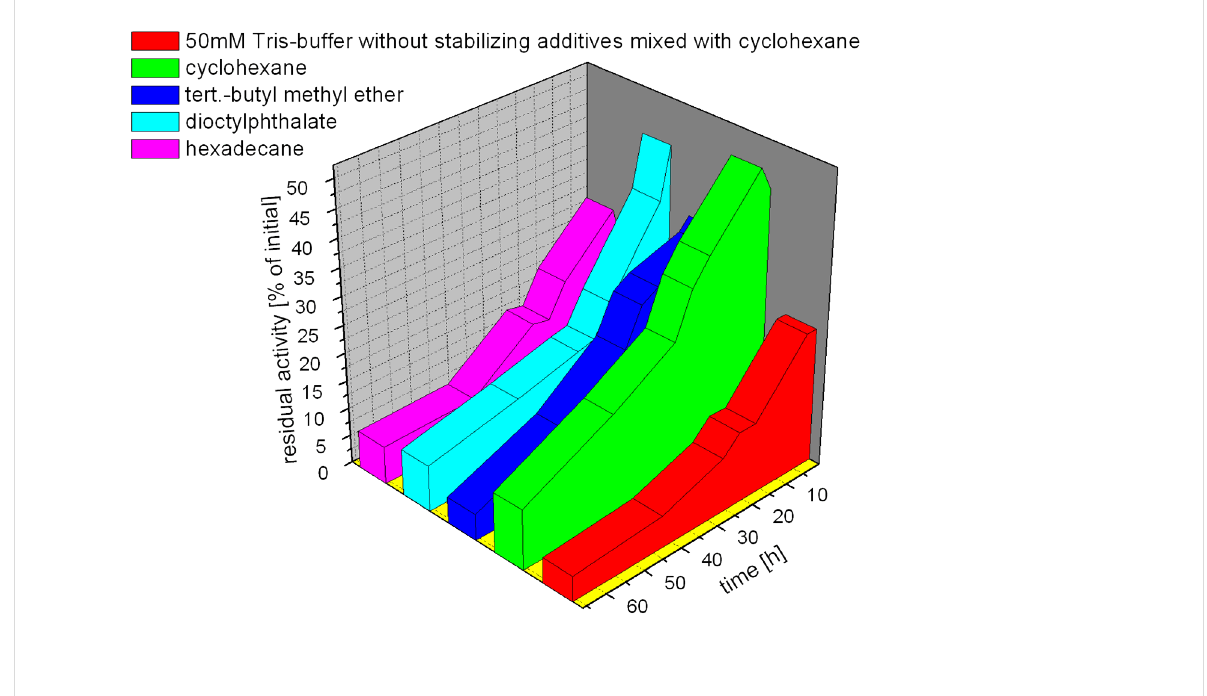
Figure 2: Effect of different solvents on the stability of PAMO, measured as residual activity. For cyclohexane as second phase values in 50 mM Tris- HCl and in optimized standard buffer are given, the results for the other solvents are shown only using the standard buffer. The first data points represent the residual activity after five